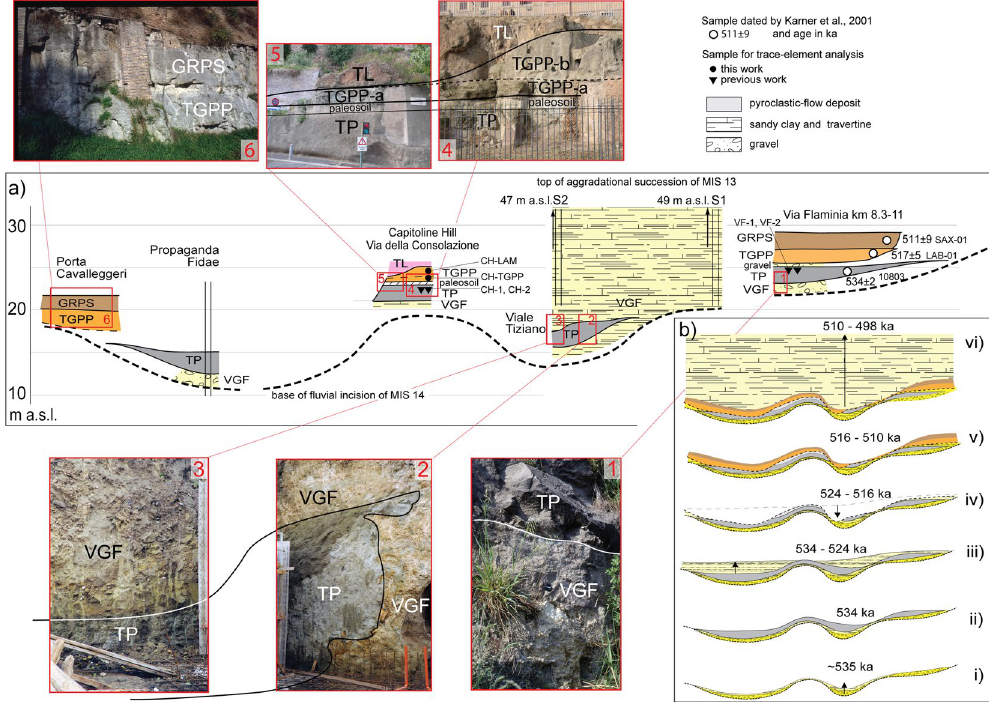
Figure 2. ( a ) composite N-S cross-section, correlating different outcrops and borehole logs along the Tiber valley (see Fig. 1 for location), showing the stratigraphic position of the pyroclastic-flow deposits of Tufo del Palatino (TP), Tufo Giallo di Prima Porta (TGPP) and Grottarossa Pyroclastic Sequence (GRPS) 24 , which are interbedded with the sedimentary deposits of the Valle Giulia Formation (VGF) 3 , and of Tufo Lionato (TL). ( b ) Reconstruction of the erosional/depositional phases during aggradation of the VGF, showing the occurrence of an early aggradational phase coeval with emplacement of TP (I-II-III), followed by a regression coeval with emplacement of TGPP (IV-V) and by a new aggradational phase (VI); reported ages according to this study (see text for